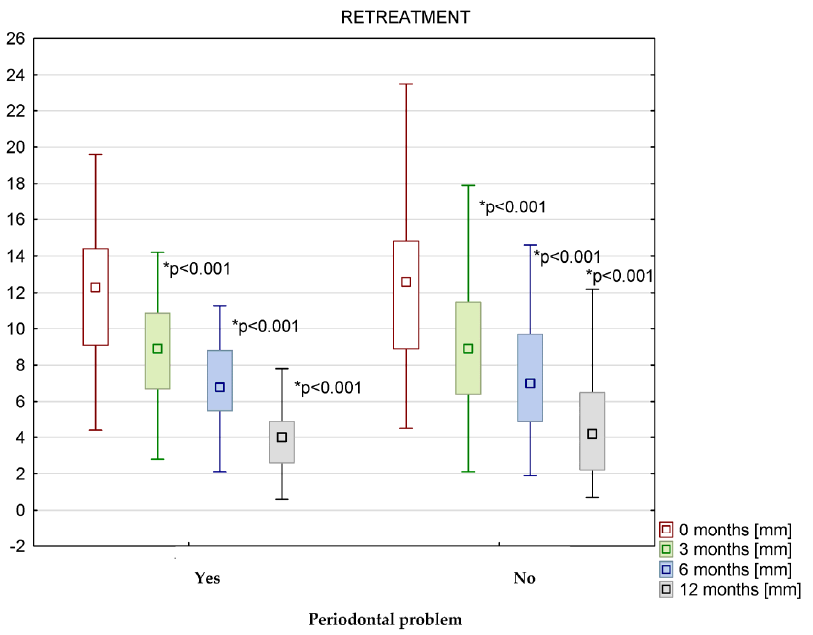
Figure 4. The thickness of changes in Schneiderian membrane in mm from 0 to 12 months after secondary treatment with and without periodontal problems.